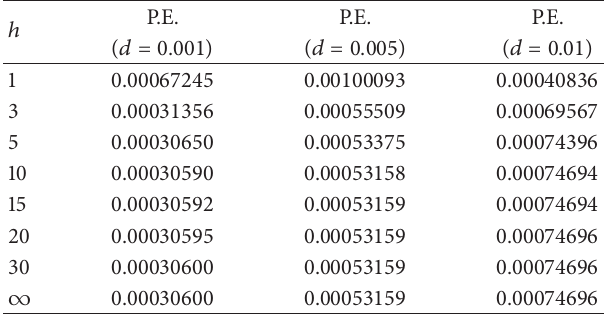
Table 2: P.E. for (44) with different plate thicknesses and various water depths ℎ .